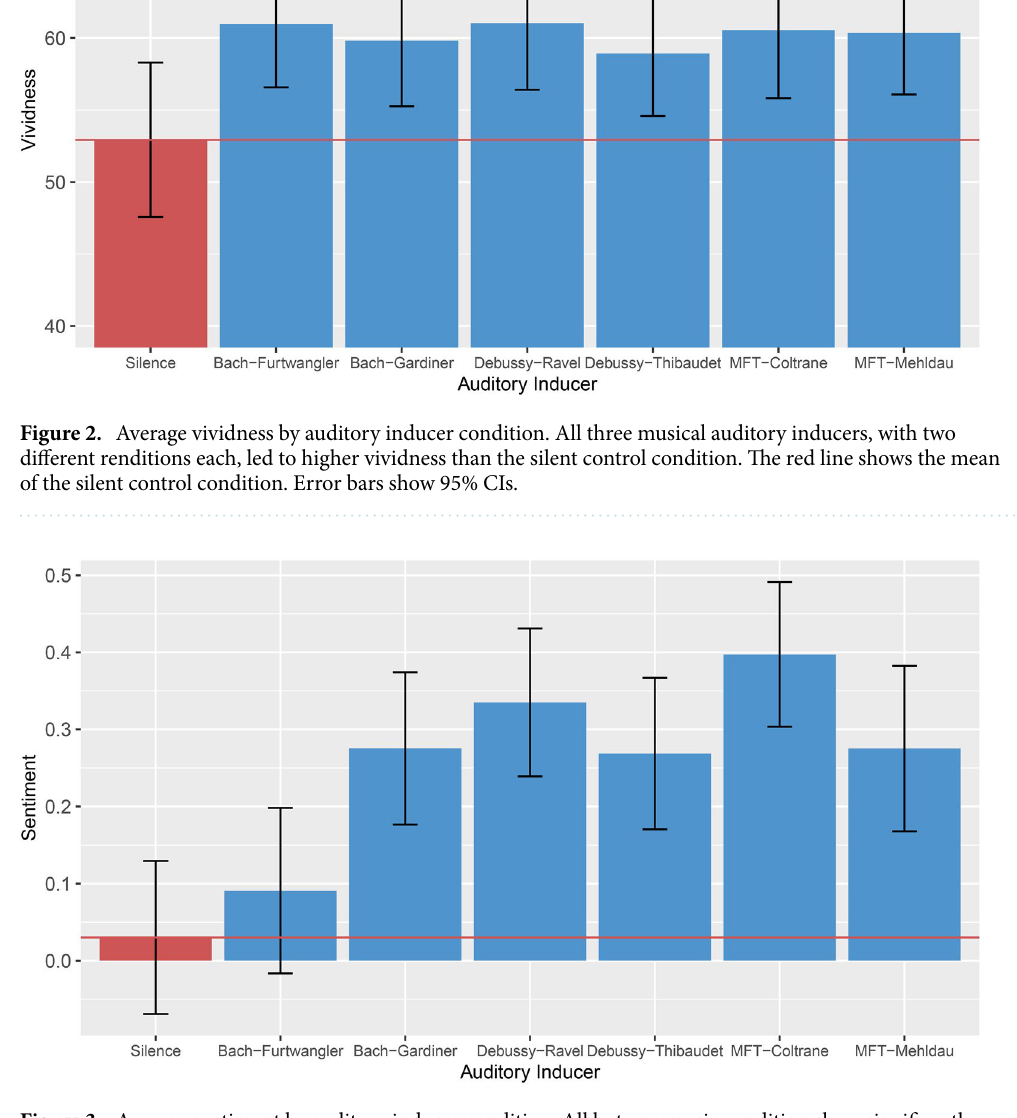
Figure 3. Average sentiment by auditory inducer condition. All but one music condition show significantly more positive sentiment in the description of the imagined journeys compared to the silence condition. Differences between renditions of the same musical piece were also observed. The red line shows the mean of the silent control condition. Error bars show 95%